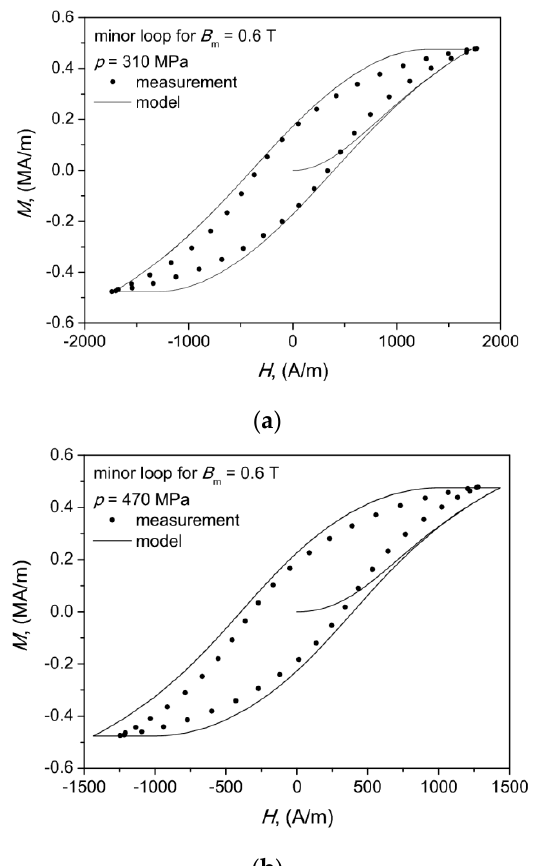
Figure 8. Modeled hysteresis curves for B m = 0.6 T: case ( a )—for 310 MPa, case ( b )—for 470 MPa. Dots denote measurement points.